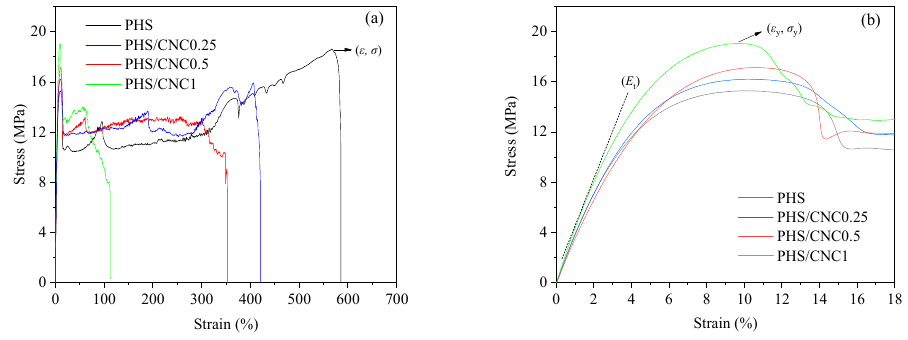
Figure 9. ( a ) whole and ( b ) initial stress-strain curves of PHS and PHS/CNC composites. Table 2. Tensile mechanical property data of PHS and PHS/CNC composites.